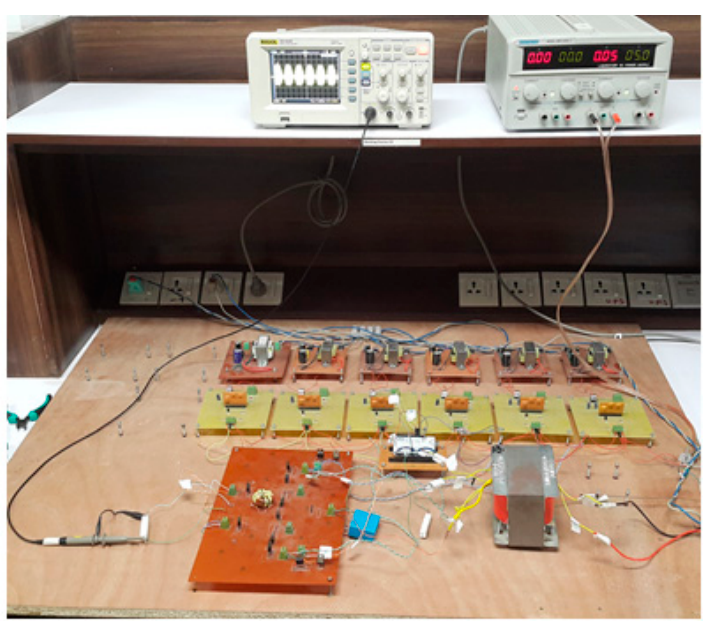
Figure 9. Practical setup.